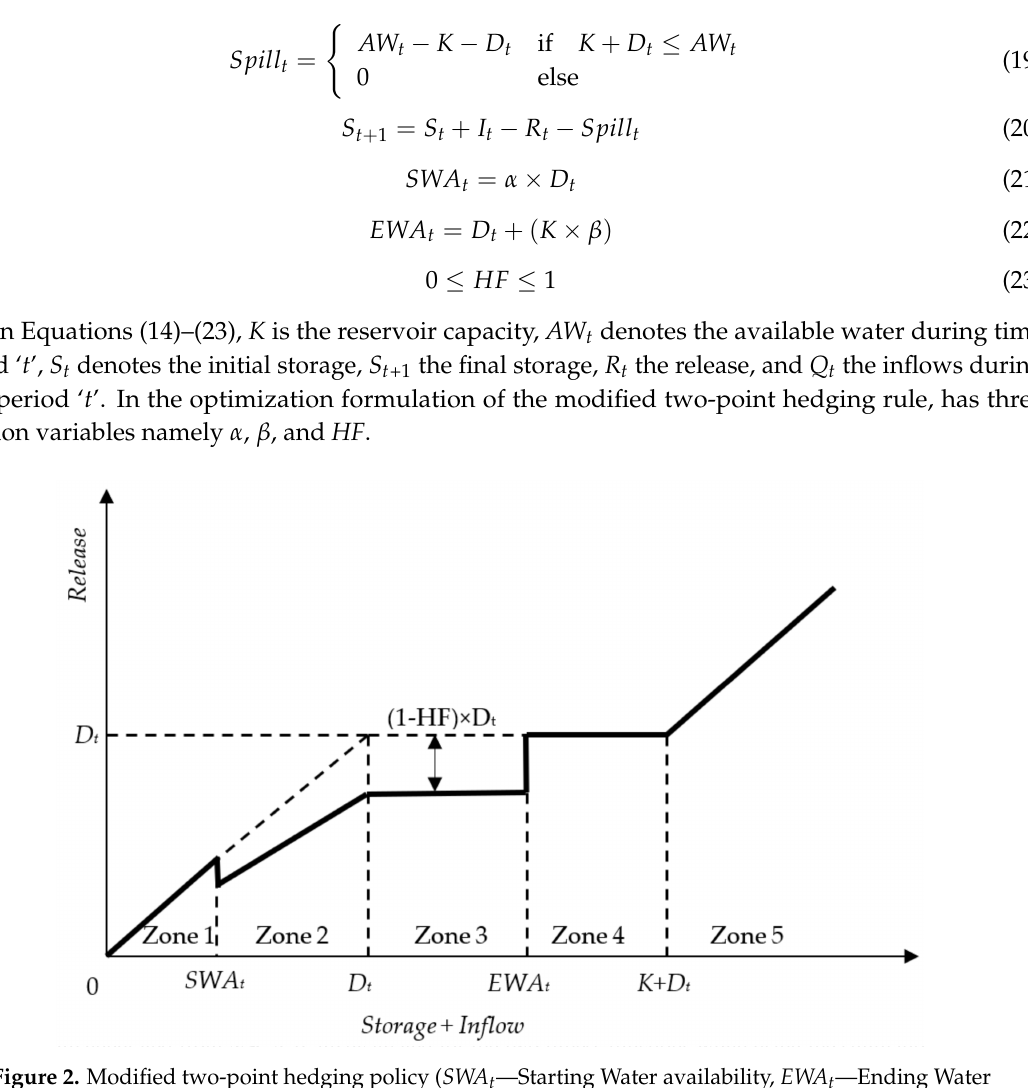
Figure 2. Modified two-point hedging policy ( SWA t —Starting Water availability, EWA t —Ending Water availability, D t —Demand, HF–Hedging Factor; and, t denotes the time period). Modified two-point hedging